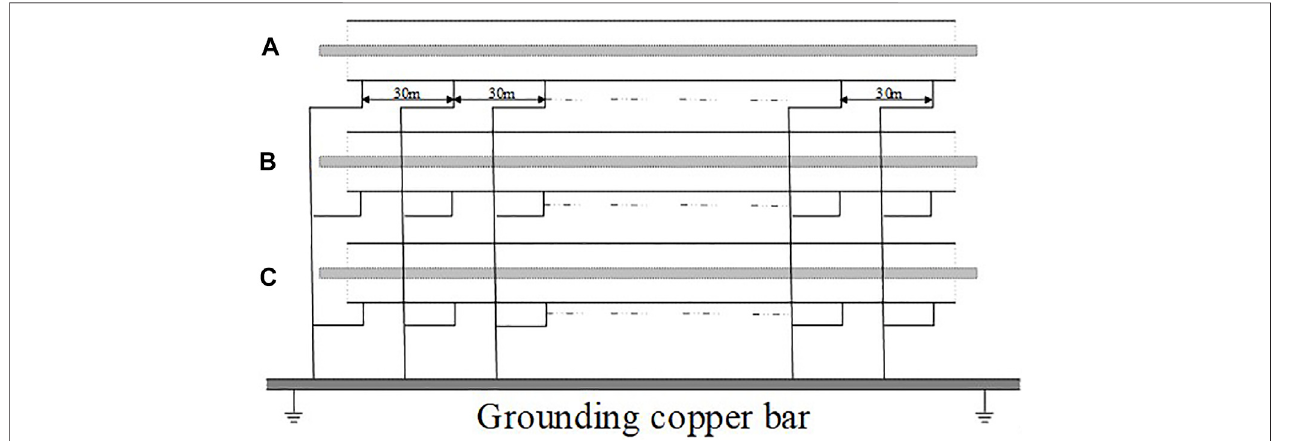
FIGURE 2 | Schematic diagram of grounding method of actual GIL